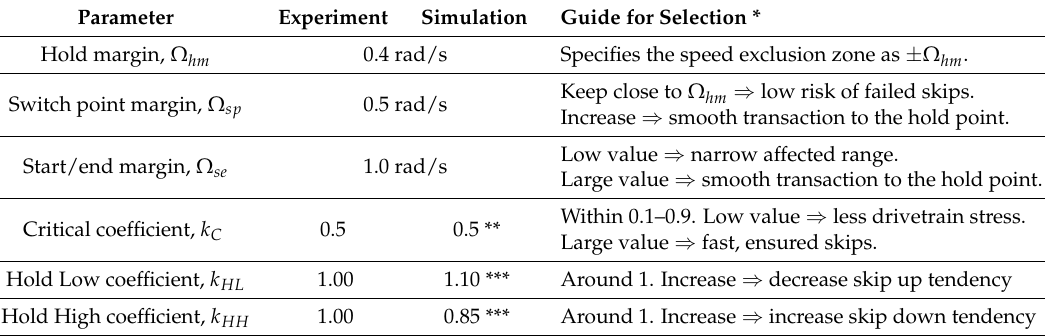
Table 2. The design parameters for the critical speed